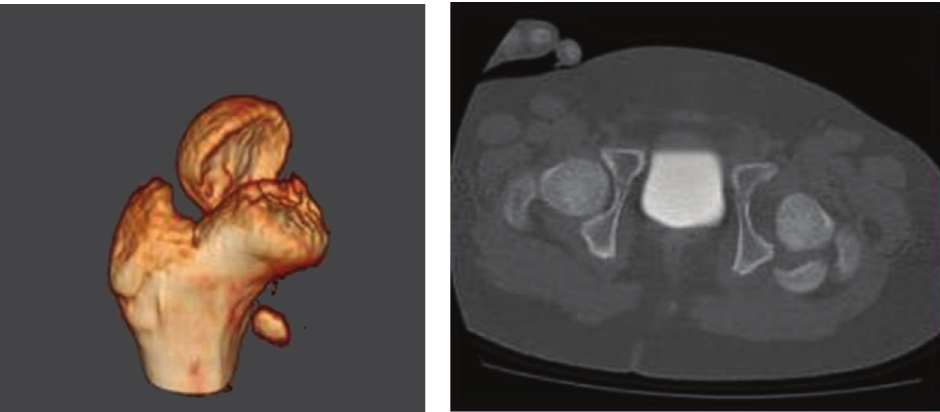
Figure 2: Preoperative computerized tomography imaging of the